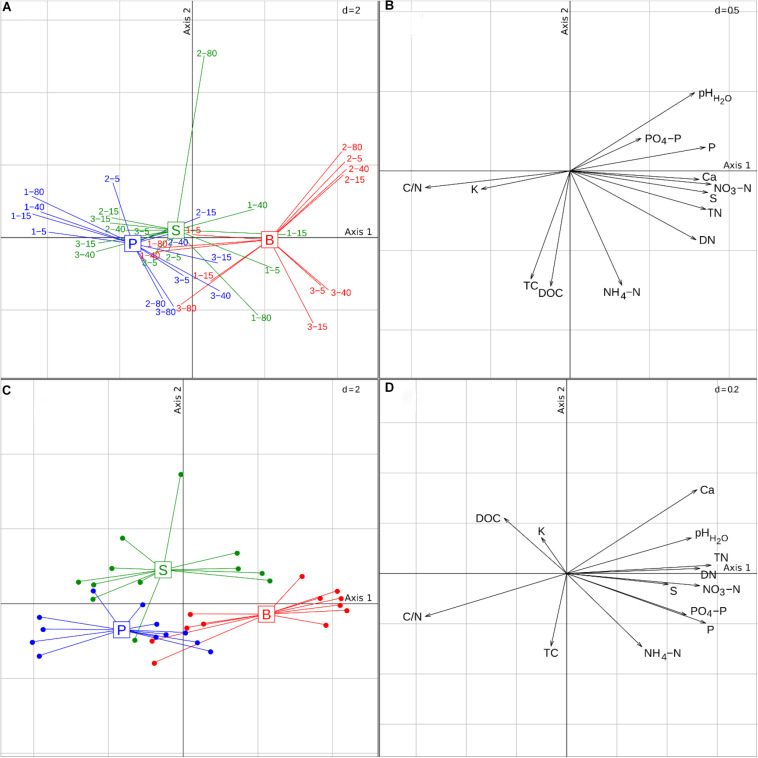
Ordination plots of the soil samples based on principal component analysis (PCA) and between-group PCA of the soil chemical variables. Scatterplots of samples (A) according to two first principal axes are shown, and correlation of soil chemical parameters with these axes (B). Plots (C,D) are scatterplots of samples according to two first principal axes and correlation of soil chemical parameters with these axes in the case of between-group PCA. Samples are connected with lines to the respective group centroid. The first two principal components explain 49.4 and 16.2% of overall data variation, respectively. Abbreviations: B, birch forest; P, pine forest; S, spruce forest; abbreviations of soil chemical variables are given in Table 2.